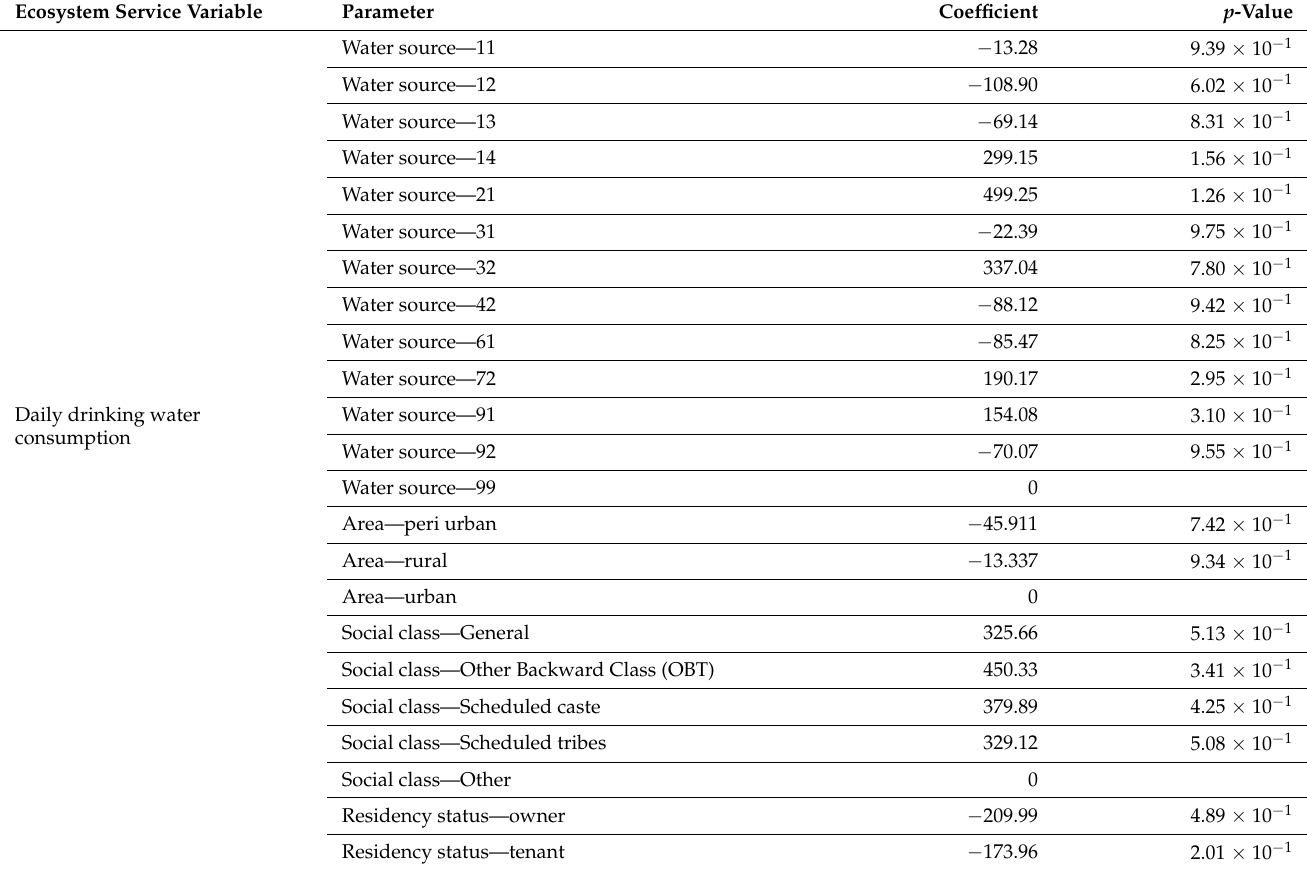
Table A7. Beneficiary travel distance (for variable descriptions see Appendix